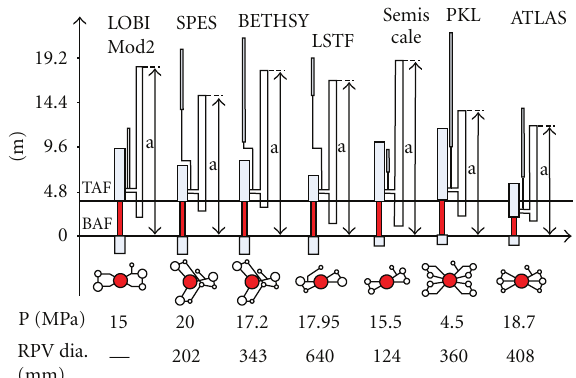
Figure 2: Comparison of ATLAS with the other